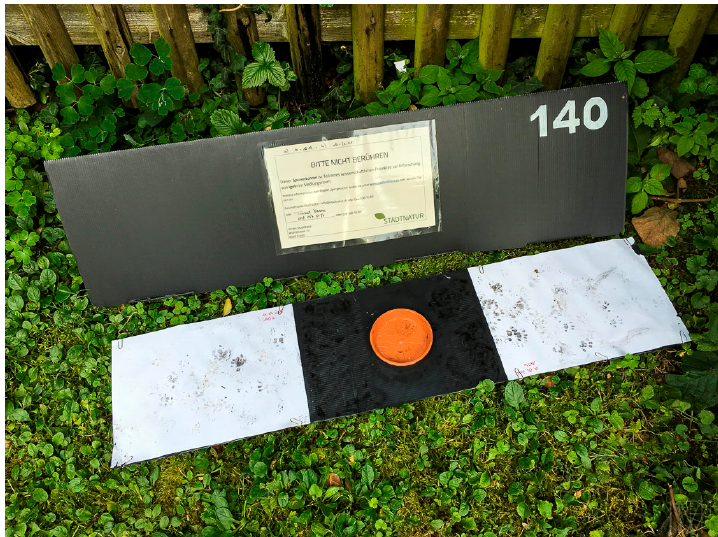
Figure A1. Footprint tunnel with removable plate in front, showing hedgehog footprints on them. Two paper sheets and two brushes of ink are applied to it. A spoon of bait is placed in the brown plate. © Thomas Massie/stadtwildtiere.ch.